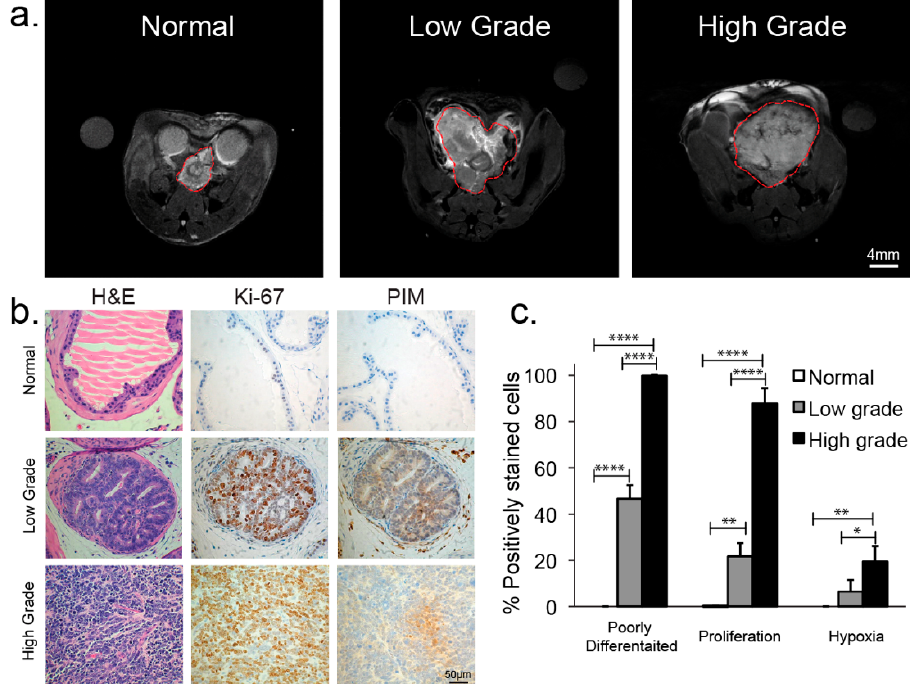
Figure 3. ( a ) Representative T 2 -weighted anatomic images of the normal murine prostate, low-grade and high-grade prostate cancer. ( b ) Immunochemical staining of excised representative normal murine prostate and low- and high-grade transgenic mouse model of prostate cancer (TRAMP) tumors; H&E section, Ki-67 staining, and Pimonidazole (PIM) staining (200× magnification). ( c )